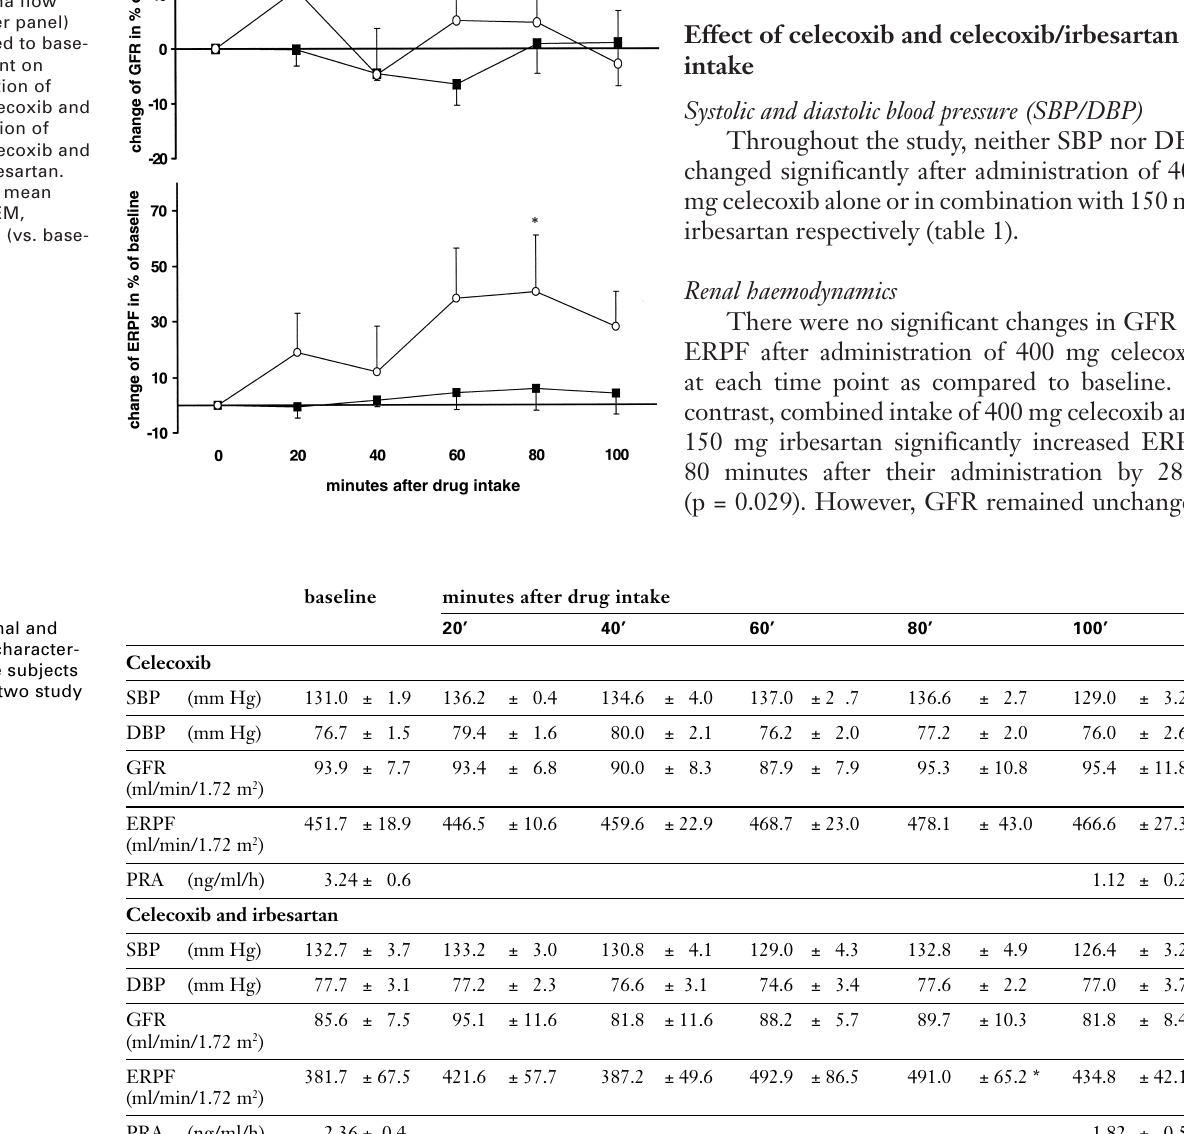
Relative changes in glomerular filtration rate (GFR; upper panel) and effective renal plasma flow (ERPF, lower panel) as compared to base- line resultant on administration of 400 mg celecoxib and a combination of 400 mg celecoxib and 150 mg irbesartan. Results are mean values ± SEM, *: p = 0.029 (vs. base- line).